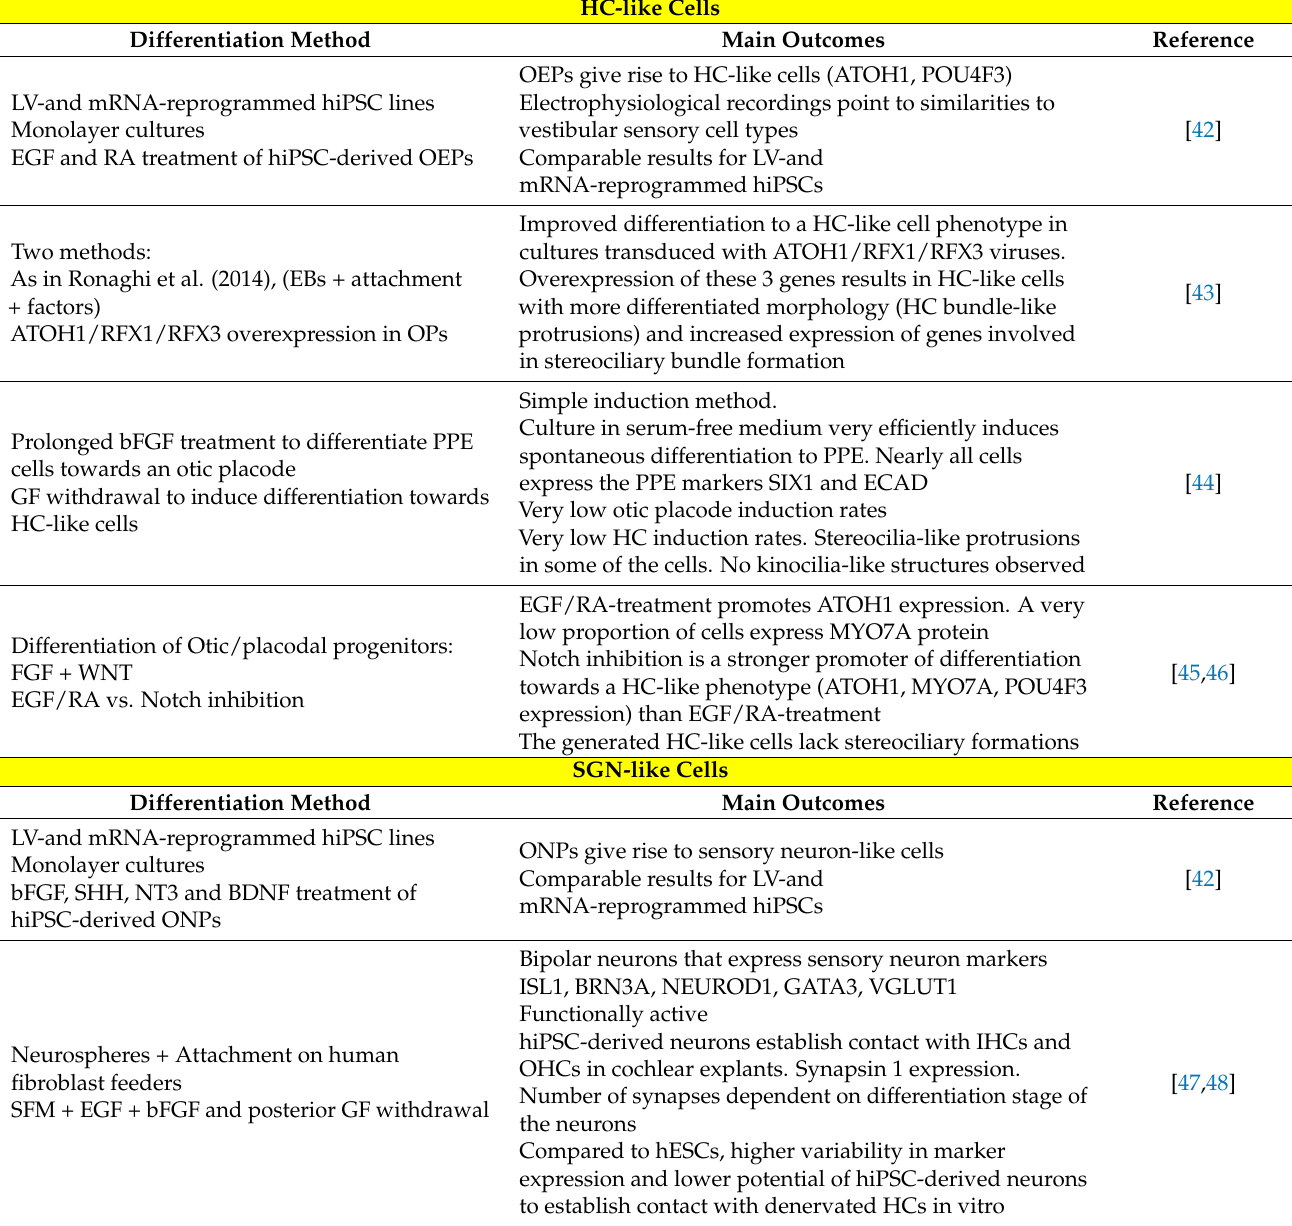
Table 1. In vitro inner ear cell models that have been derived from